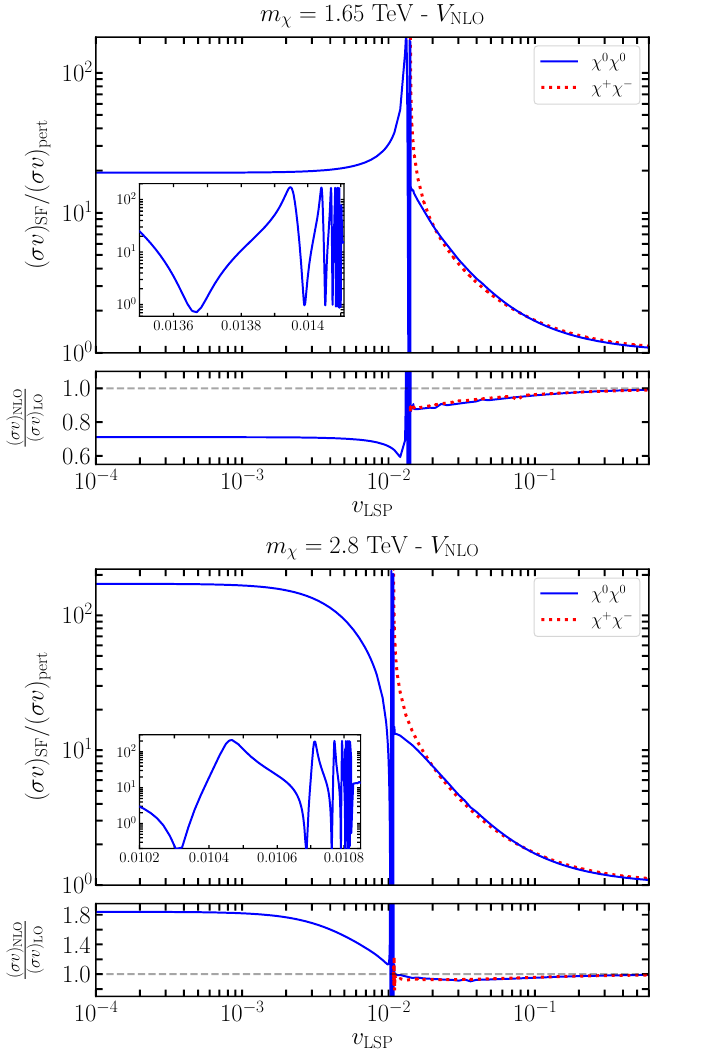
Figure 6 . The Sommerfeld factors for the two channels χ 0 χ 0 and χ + χ − computed with the NLO potential for m χ = 1 . 65 TeV (upper panel) and 2 . 8 TeV (lower panel). The inset zooms into the p region around v LSP = 2 δm χ /m χ , where Coulomb bound states cause a rapid oscillation in the Sommerfeld factor. Below each panel, the effect of the NLO correction to the potential is highlighted by showing the ratio of the NLO to the LO Sommerfeld